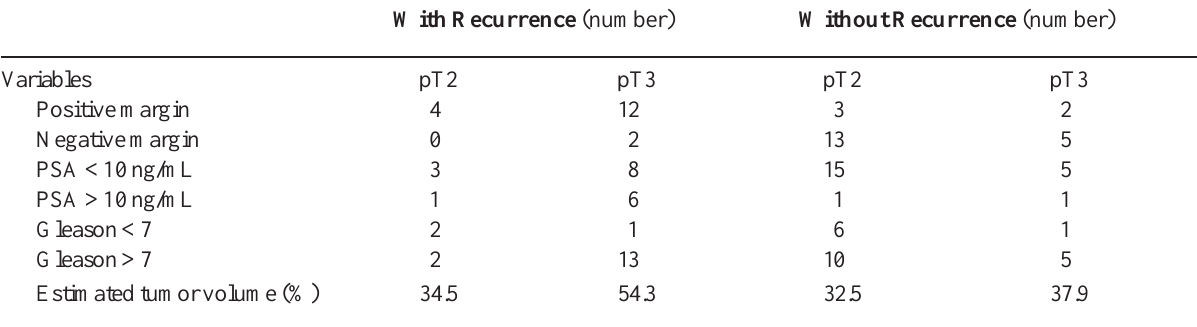
Table 3 – Clinical and morphologic variables associated to postoperative